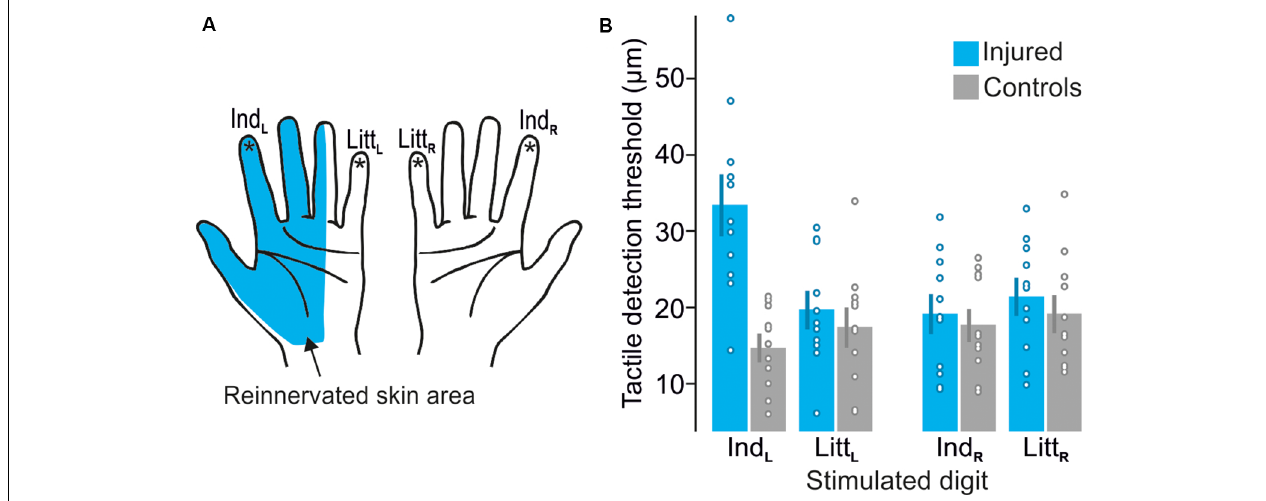
FIGURE 2 | Test sites and detection thresholds recorded during the tactile threshold-tracking task. (A) Schematic illustration of the reinnervated skin area after median nerve transection and repair. Stars indicate tested sites: left index (Ind L ), left little (Litt L ), right index (Ind R ) and right little (Litt R ) fingertips. (B) Tactile detection thresholds for median nerve-injured and control participants when stimulating each tested fingertip given as peak-to-peak amplitude of the ridge movement. Heights of columns give mean values computed across participants, error bars indicate ± 1 SEM ( n = 11) and symbols indicate tactile thresholds for individual